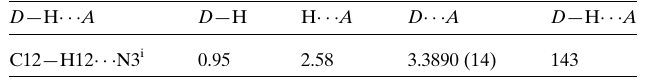
Table 1 Hydrogen-bond geometry (A˚ , (cid:3) ) for I